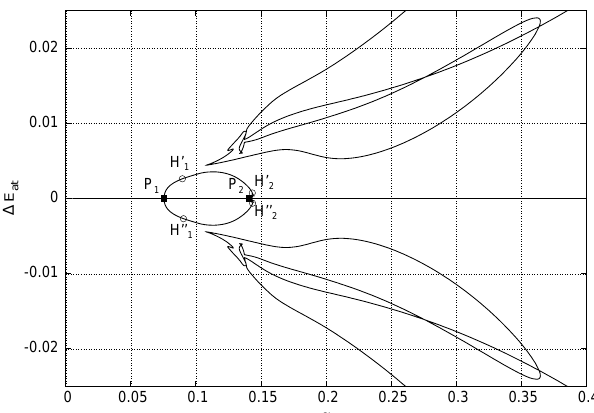
Fig. 5: Bifurcation diagram for the atmospheric equilibria at σ =0 . 65 . The asymmetry measure Fig. 5. Bifurcation diagram for the atmospheric equilibria at σ = ∆ E at is computed in the same manner as in Fig. 2 for the ocean but as a function of the parameter 0 . 65 . The asymmetry measure 1E at is computed in the same man- α . All branches, whether stable or not, are shown as solid lines, for legibility. On the steady-state ner as in Fig. 2 for the ocean but as a function of the parameter α . branches, we only plot — as open circles — the Hopf bifurcations for which the period exceeds 50 All branches, whether stable or not, are shown as solid lines, for days. P 1 is a supercritical pitchfork bifurcation and P 2 is a subcritical one. The shape of the SST legibility. On the steady-state branches, we only plot – with circles forcing used here is similar to Fig. 3c. – the Hopf bifurcations for which the period exceeds 50 days. P 1 is a supercritical pitchfork bifurcation, and P 2 is a subcritical one. The shape of the SST forcing used here is similar to Fig.